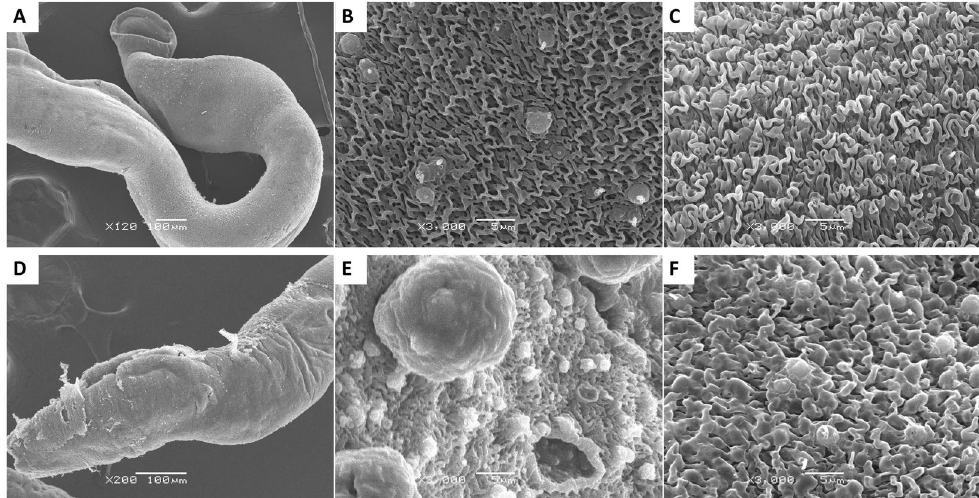
Figure 3. Scanning electron microscopy analysis of schistosomes after siRNA treatment. ( A , B , C ) Morphology of S . japonicum in the control group. ( A ) Anterior portion of a male schistosome under low magnification (120 × ). ( B ) Anterior portion of a male schistosome indicating the presence of a few crests and sensory papillae (3000 × ). ( C ) Highly-folded medial and posterior portions of a male schistosome showing a sponge-like appearance (3000 × ). ( D , E , F ) Morphology of male schistosomes treated with SjVAMP2 siRNA. ( D ) Peeling of the anterior region of the tegument of a male schistosome (200 × ). ( E ) Tegument with many abnormally oversized bulb-like structures, some of which collapsed (3000 × ). ( F ) Medial and posterior portions of the tegument with fused sponge-like ridges (3000 ×